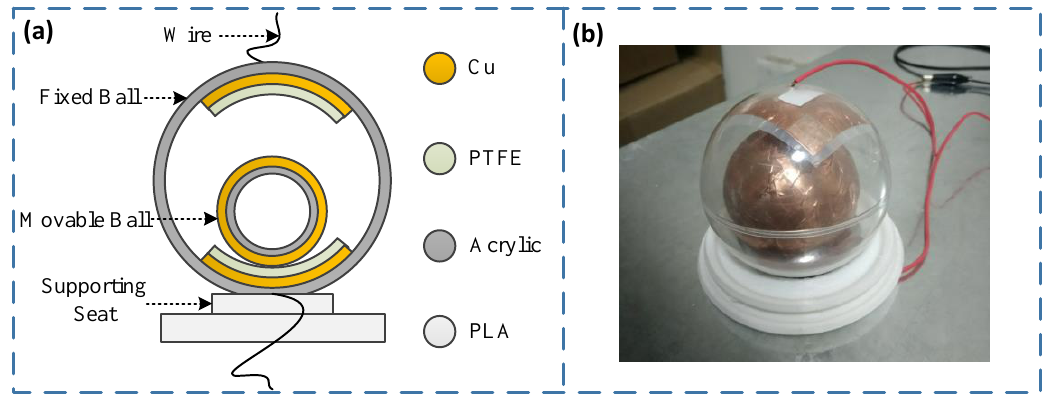
Figure 2. Composition of the S-TENG. ( a ) Composition schematic diagram; ( b ) A picture of the S- TENG.